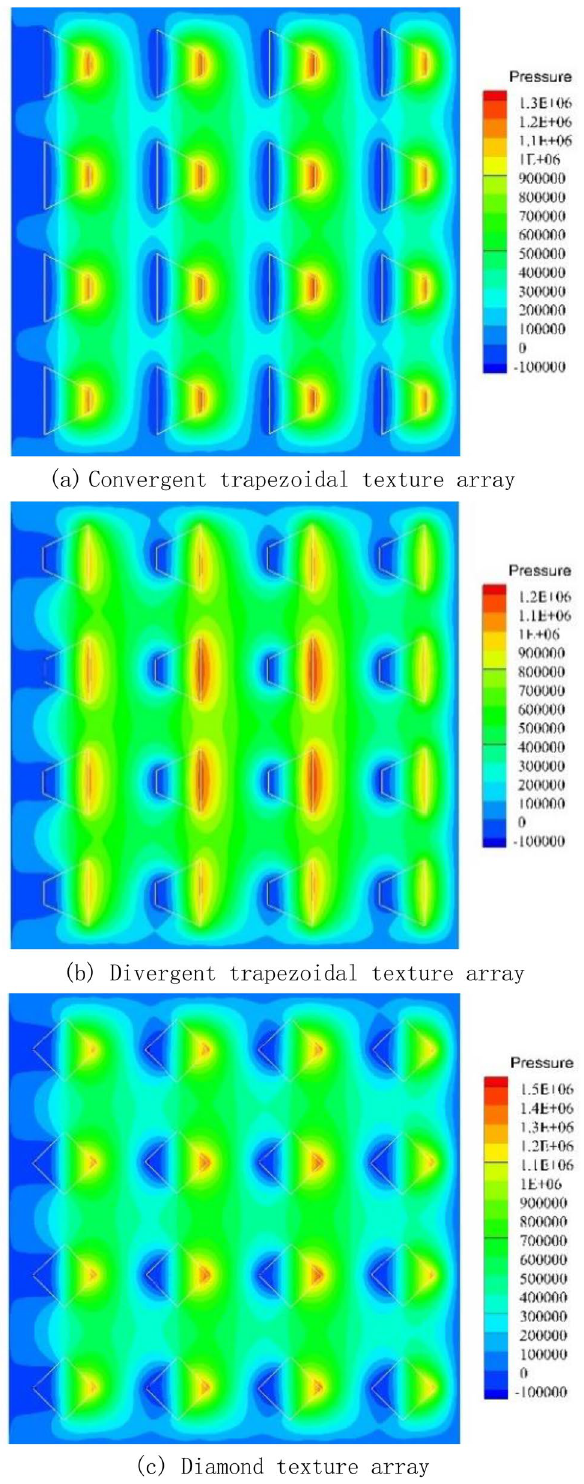
Figure 4. Pressure